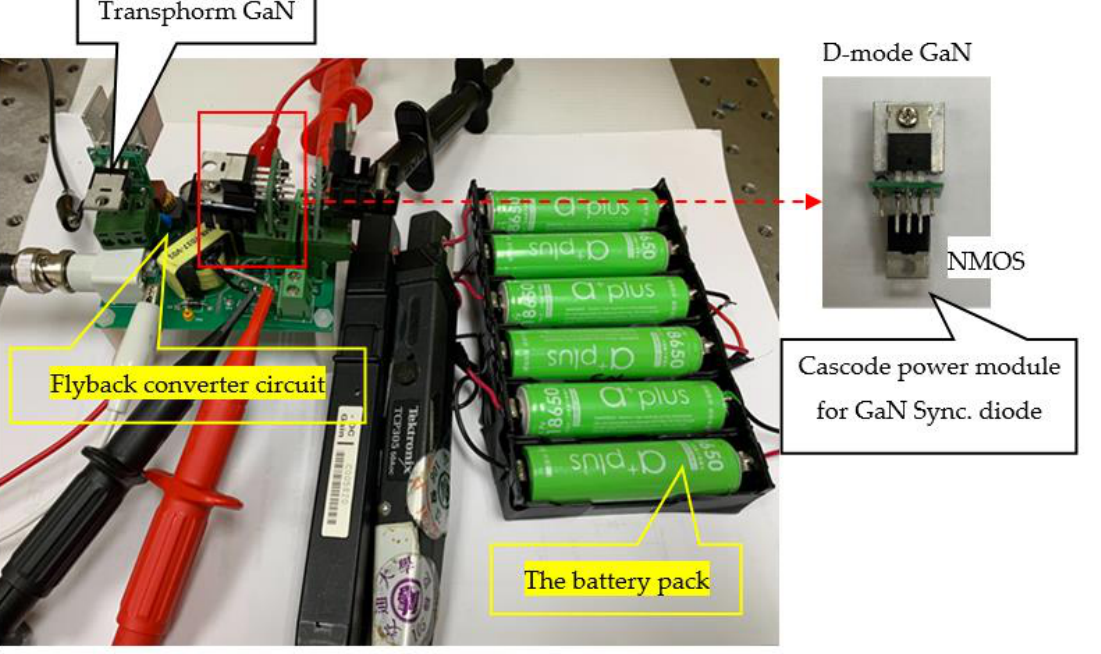
Figure 11. The photograph of flyback experiment setup with D-Mode GaN HEMT Synchronous Rectifier.